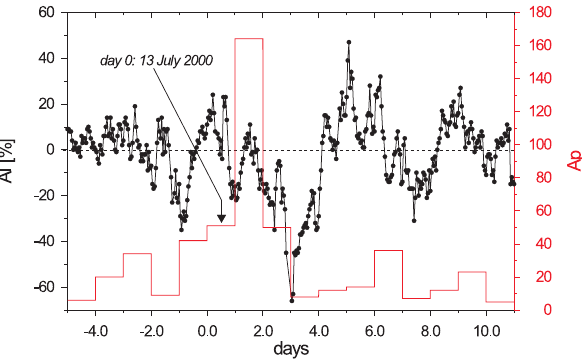
Fig. 15. Variations of hourly AI values in mid-latitudes (black) and daily geomagnetic Ap values (red) in connection with the iono- spheric storm in July 2000.